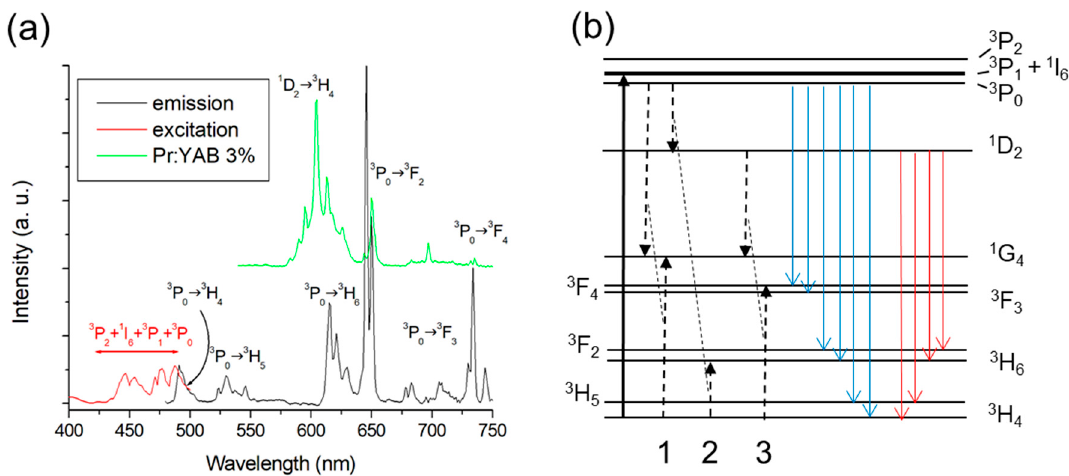
Figure 2. ( a ) Excitation (monitored wavelength: 613 nm) and emission (excitation at 450 nm) spectrum of PrAB and of Pr 3+ :YAB. ( b ) Energy levels scheme and de-excitation mechanisms.